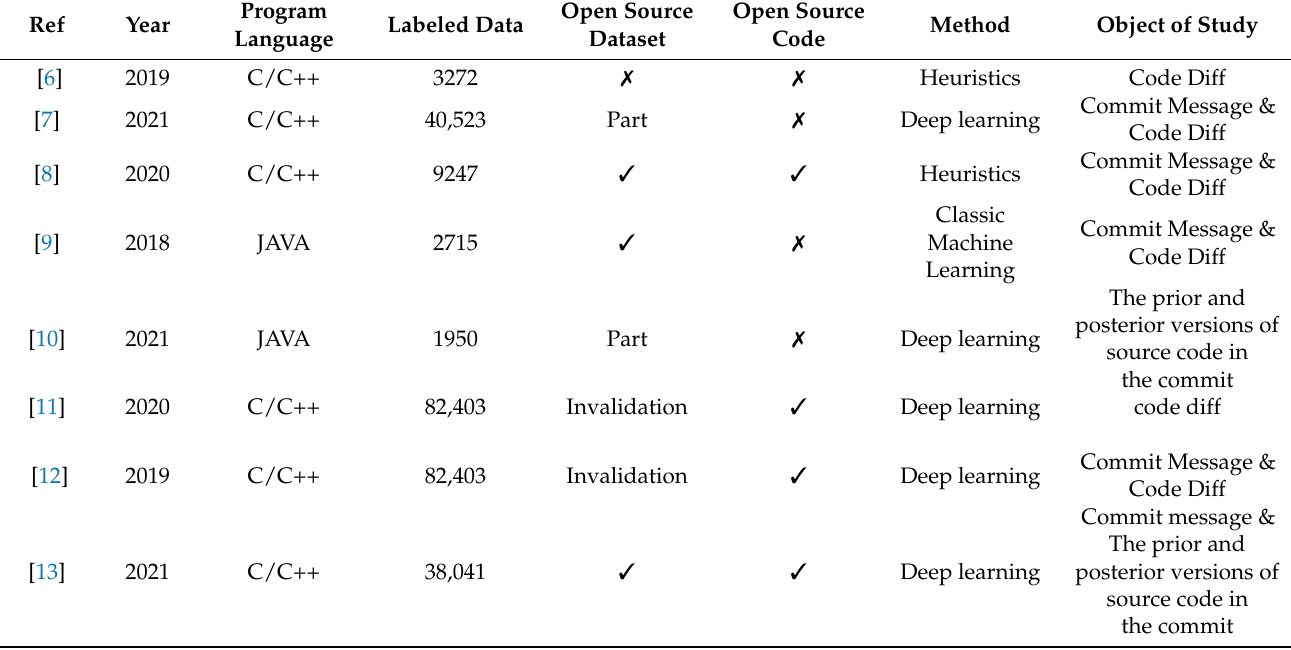
Table 1. The related work in the security patch